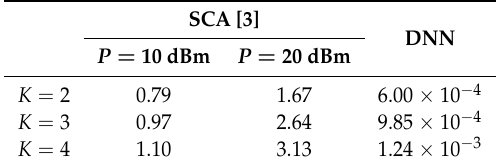
Table 1. Average CPU Running Time